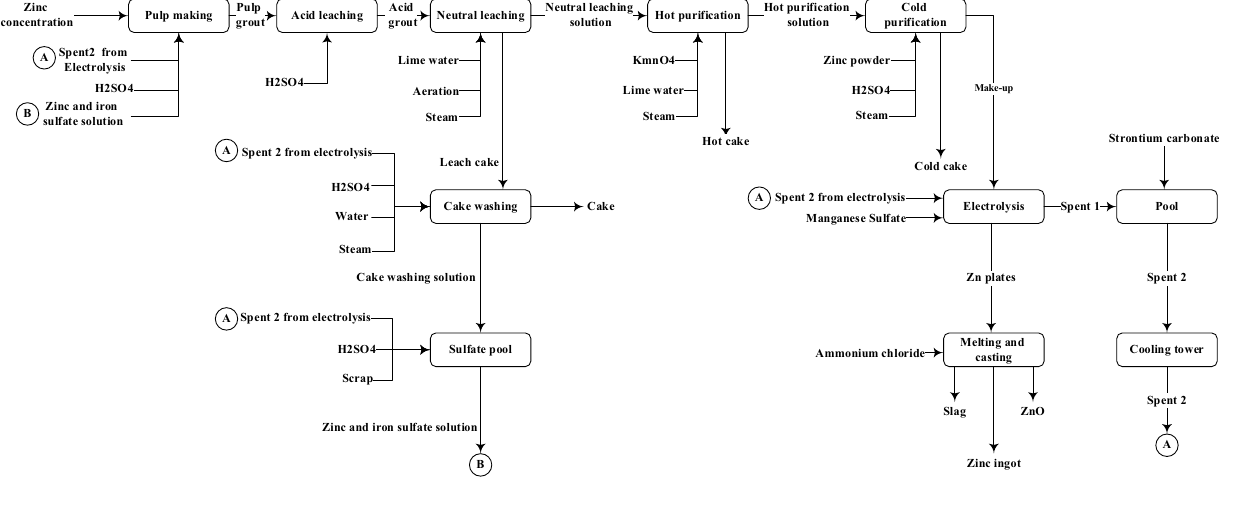
Fig. 1 Zinc ingot process schematic Table 2 Chemical composition of zinc ingots with grade Zn-3